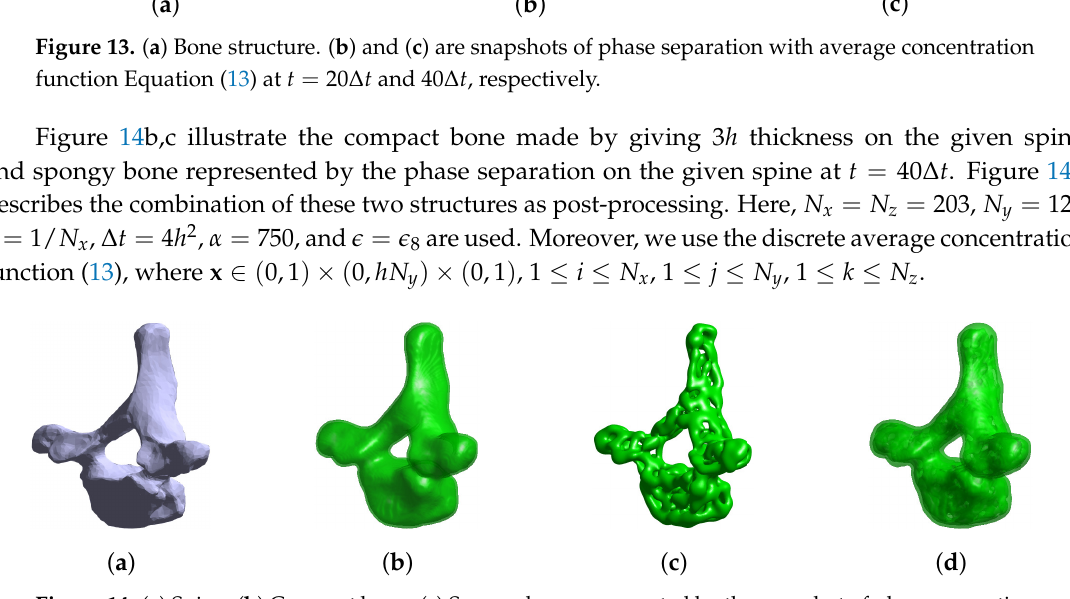
Figure 14. ( a ) Spine. ( b ) Compact bone. ( c ) Spongy bone represented by the snapshot of phase separation with average concentration function Equation (13) at t = 40 ∆ t . ( d ) Combination of ( b ) and ( c